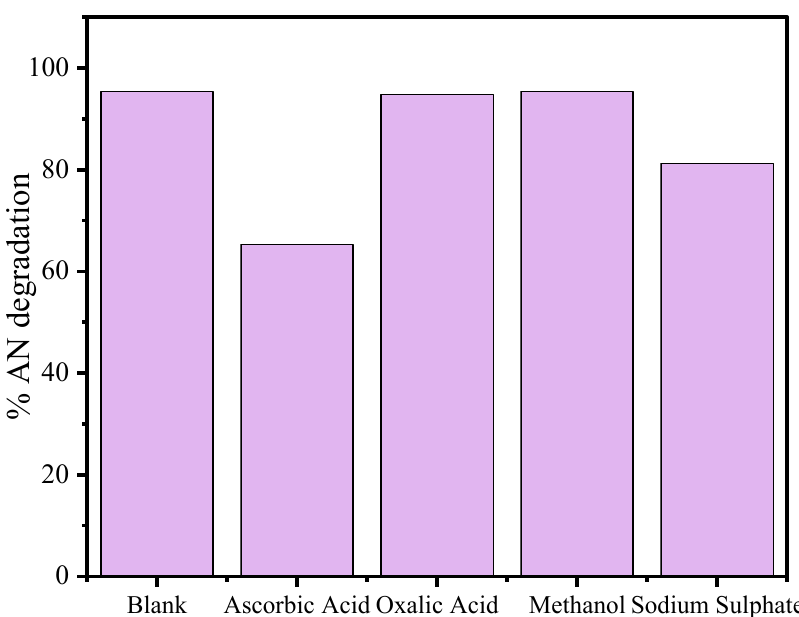
Figure 10. Scavenger test on the AN degradation by CuO/Alg-Agar BNC for determination of ROS. When visible radiation falls on the CuO/Alg-Agar BNC surface, the electrons-holes are formed (e CB − + h VB+ ) in their conduction band and valence band, respectively. Then, the appeareance of O 2 will trap the e CB − electrons and form • O 2 − (superoxide radical), which reacts with H + ions resulting in the formation of HO 2 • radical. The holes h VB + present on the surface of the catalyst will combine with H 2 O generating • OH hydroxyl radicals. These and other reactive oxidant species are responsible for the degradation of AN which results in the generation of small non-toxic products such as H 2 O, CO 2 and other